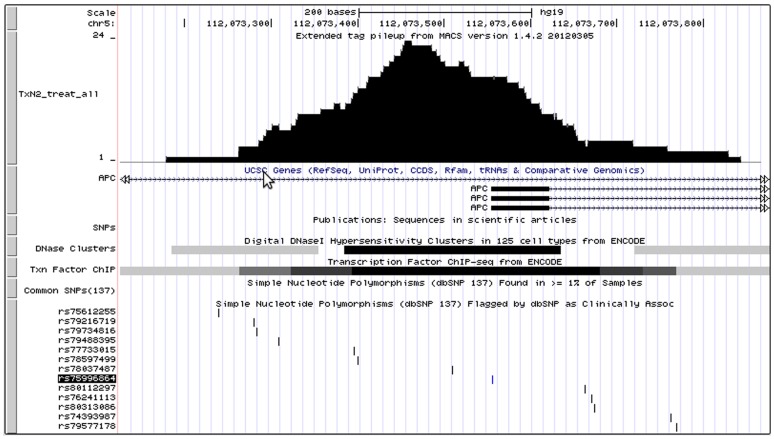
Localization of putative rSNPs within OTFR belonging to APC gene.SNPs from the different parts of OTFR were taken in EMSA to study the effect of SNP location within OTFR on the protein binding.